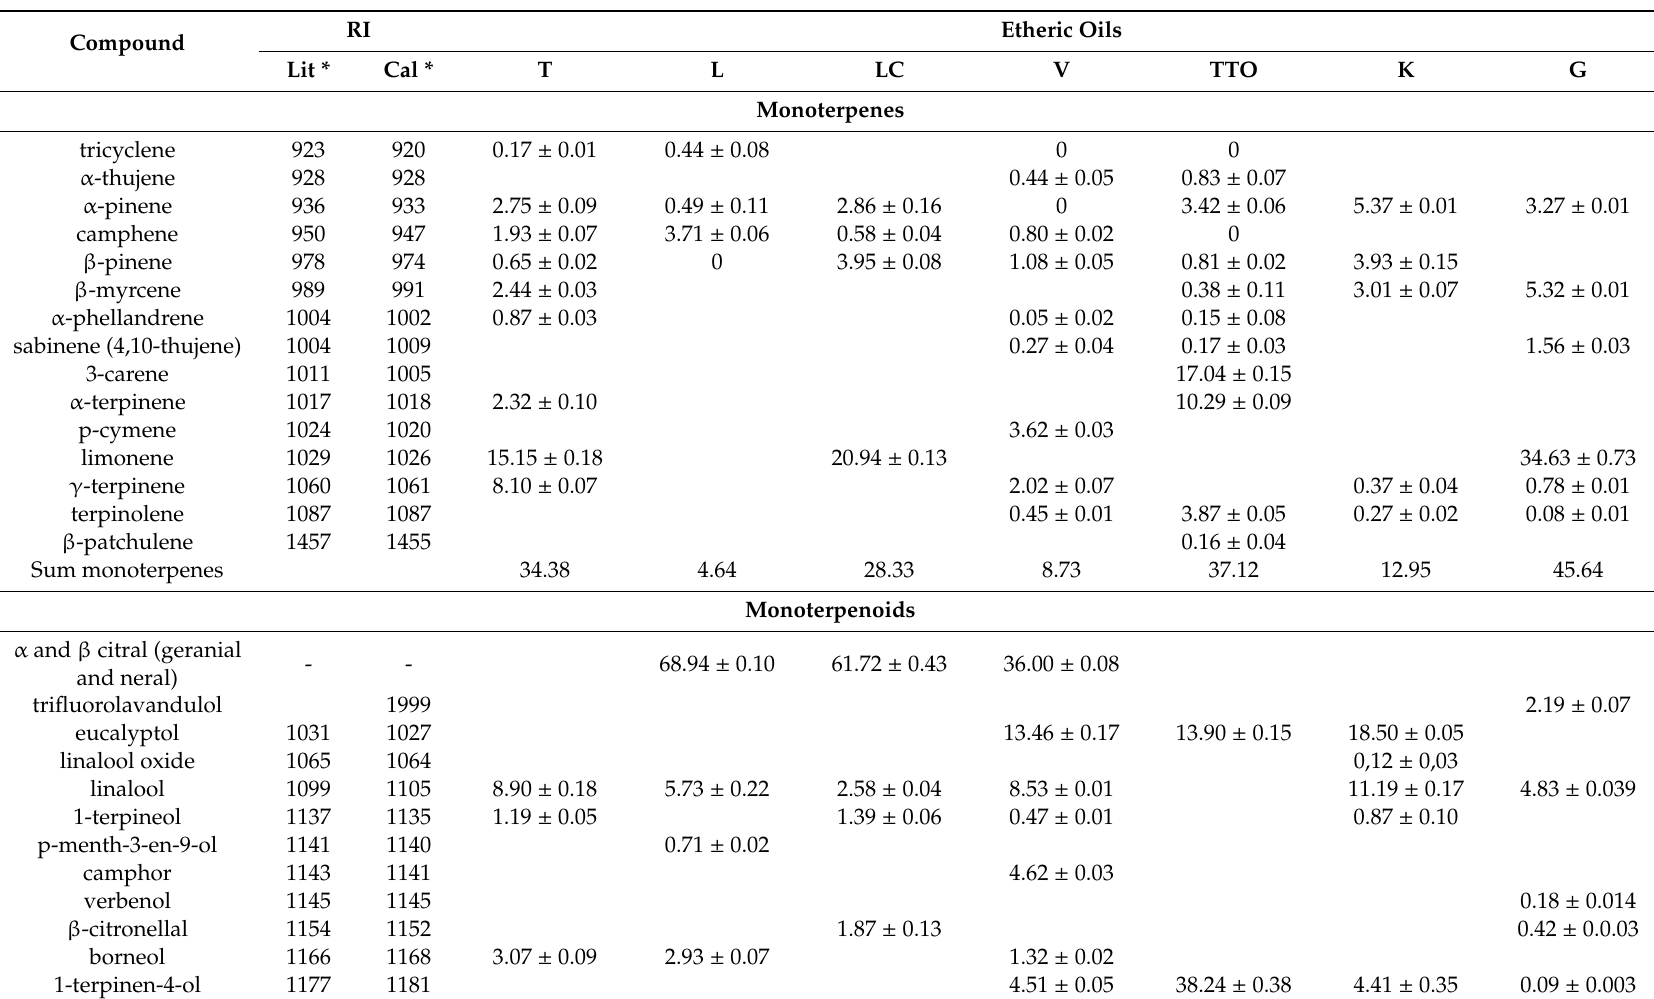
Table 2. Chemical composition of the tested essential oils in [%]: T—thyme; L—lemongrass; LC— Litsea cubeba ; V—verbena; TTO—tea tree; K—cajeput; G—grapefruit.